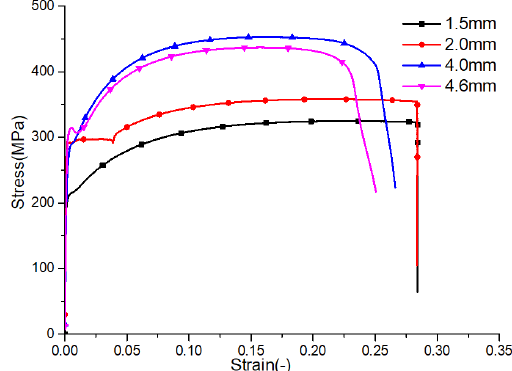
Figure 6. Dimension of the tensile test specimen. Table 2. Mechanical properties of Q235.